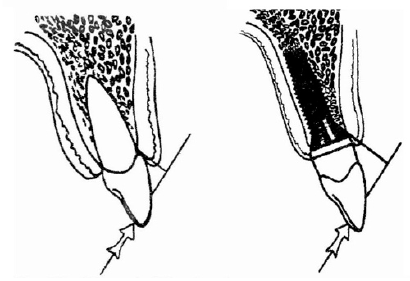
Figure 1. Peri-implant tissue reabsorbment. In the case of angled occlusal load (as shown by the teeth and dental implants respond in di ff erent arrow), teeth and dental implants respond in different ways.